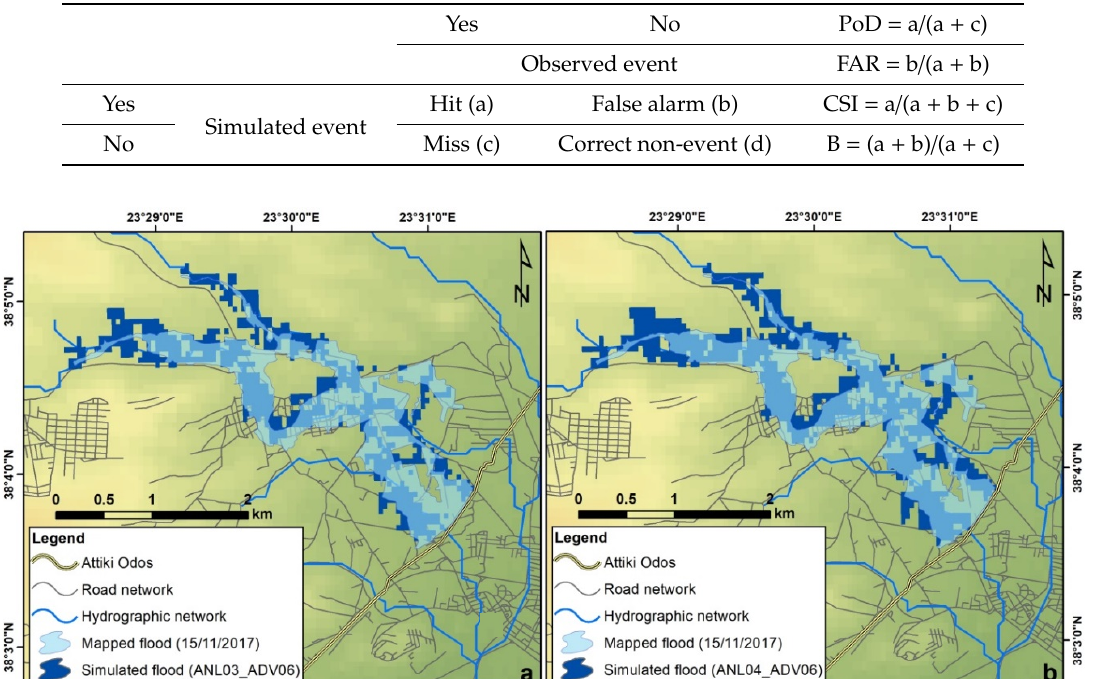
Figure 7. One hour accumulated precipitation superimposed with the simulated discharges forced by the LAPS nowcasts. WRF-Hydro simulation starting on 15 November at 04:00 UTC and going up to 08:00 UTC every hour ( a – d ), forced by the LAPS nowcasts from 05:00 to 08:00 UTC. Streams with order 4 or higher are